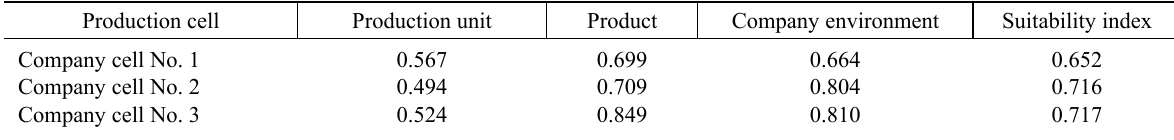
Table 6. Suitability index